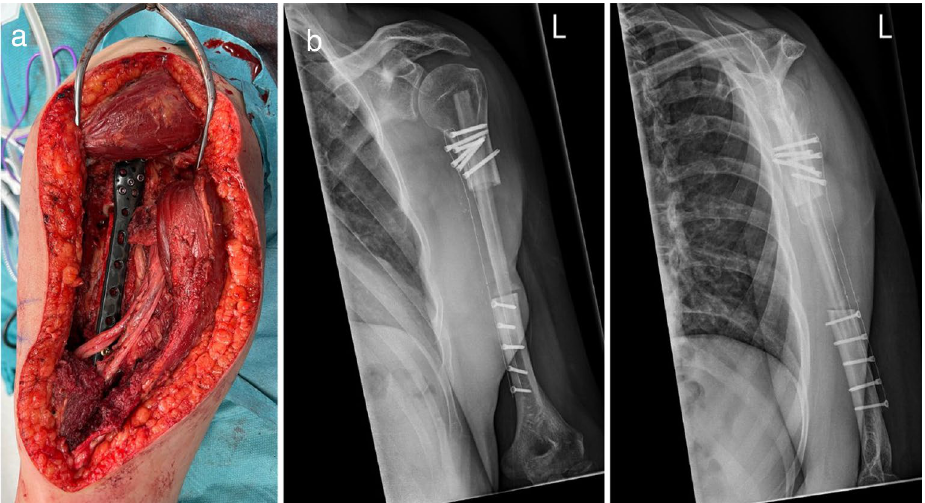
Figure 4. Intraoperative picture after midshaft resection of the left humerus and partial resection of the triceps muscle due to an Ewing Sarcoma. Reconstruction was performed with a free vascularized fibula graft and a carbon-fiber humerus plate ( a ). Postoperative anteroposterior X-rays of the same patient ( b ).